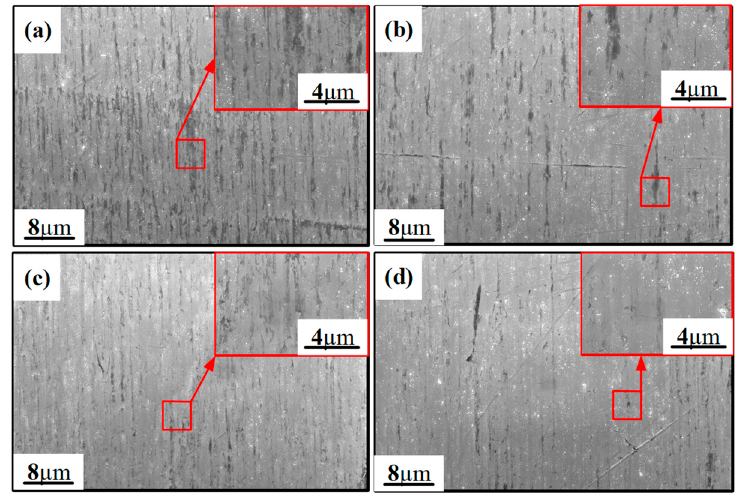
Figure 13. SEM photograph of the surface topography of Ti6Al4V alloy polished by SR and PR bonnet under different dwell times: ( a ) SR bonnet polished under a dwell time of 30 s; ( b ) SR bonnet polished under a dwell time of 300 s; ( c ) PR bonnet polished under a dwell time of 30 s; ( d ) SR bonnet polished under a dwell time of 300 s.